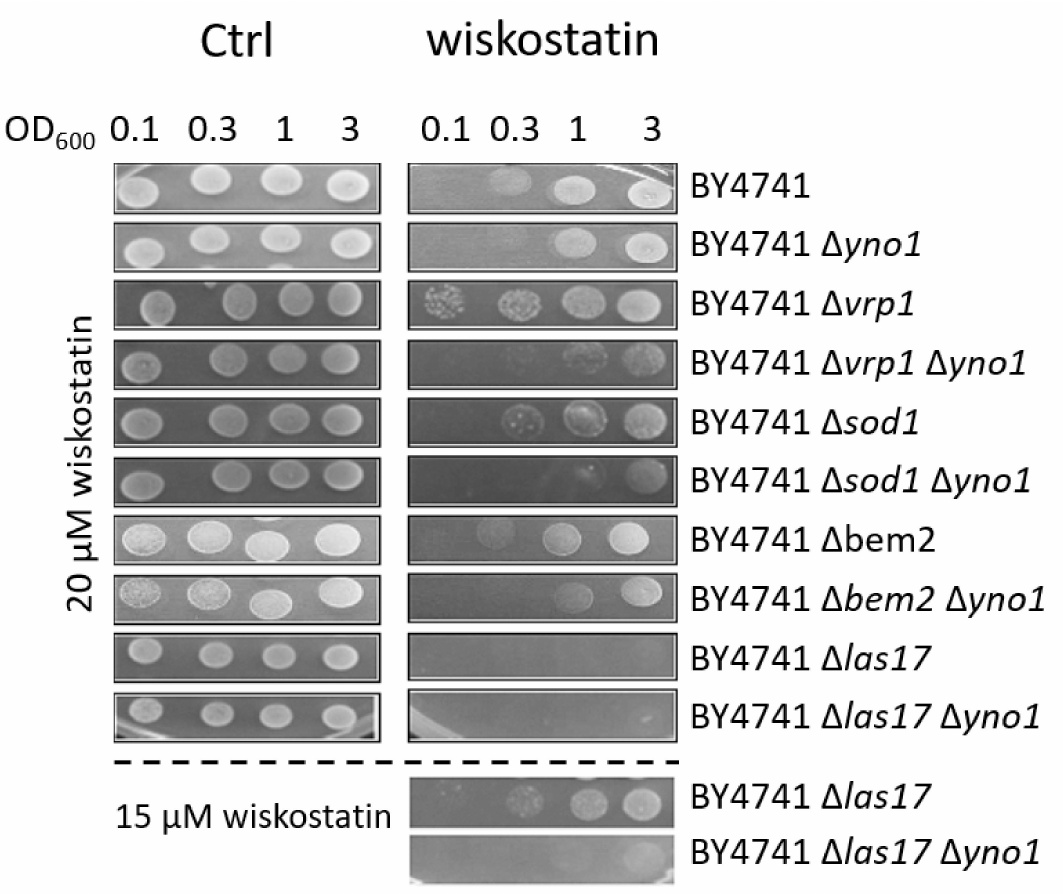
Figure 3. The sensitivity of mutants to wiskostatin by spot test analysis. Serial dilutions (OD 600 of 3, 1, 0.3, and 0.1) of the strains BY4741, BY4741 ∆ yno1 , BY4741 ∆ vrp1 , BY4741 ∆ sod1 , BY4741 ∆ bem2 , BY4741 ∆ las17 , BY4741 ∆ yno1 ∆ vrp1 , BY4741 ∆ yno1 ∆ sod1 , BY4741 ∆ yno1 ∆ bem2 , and BY4741 ∆ yno1 ∆ las17 were spotted on SC-glucose plates, SC-glucose +20 µ M wiskostatin plates and SC-glucose +15 µ M wiskostatin plates. At least three biological replicates were tested on plates containing concentrations of wiskostatin in a range from 0–100 µ M. Representative images and concentrations were